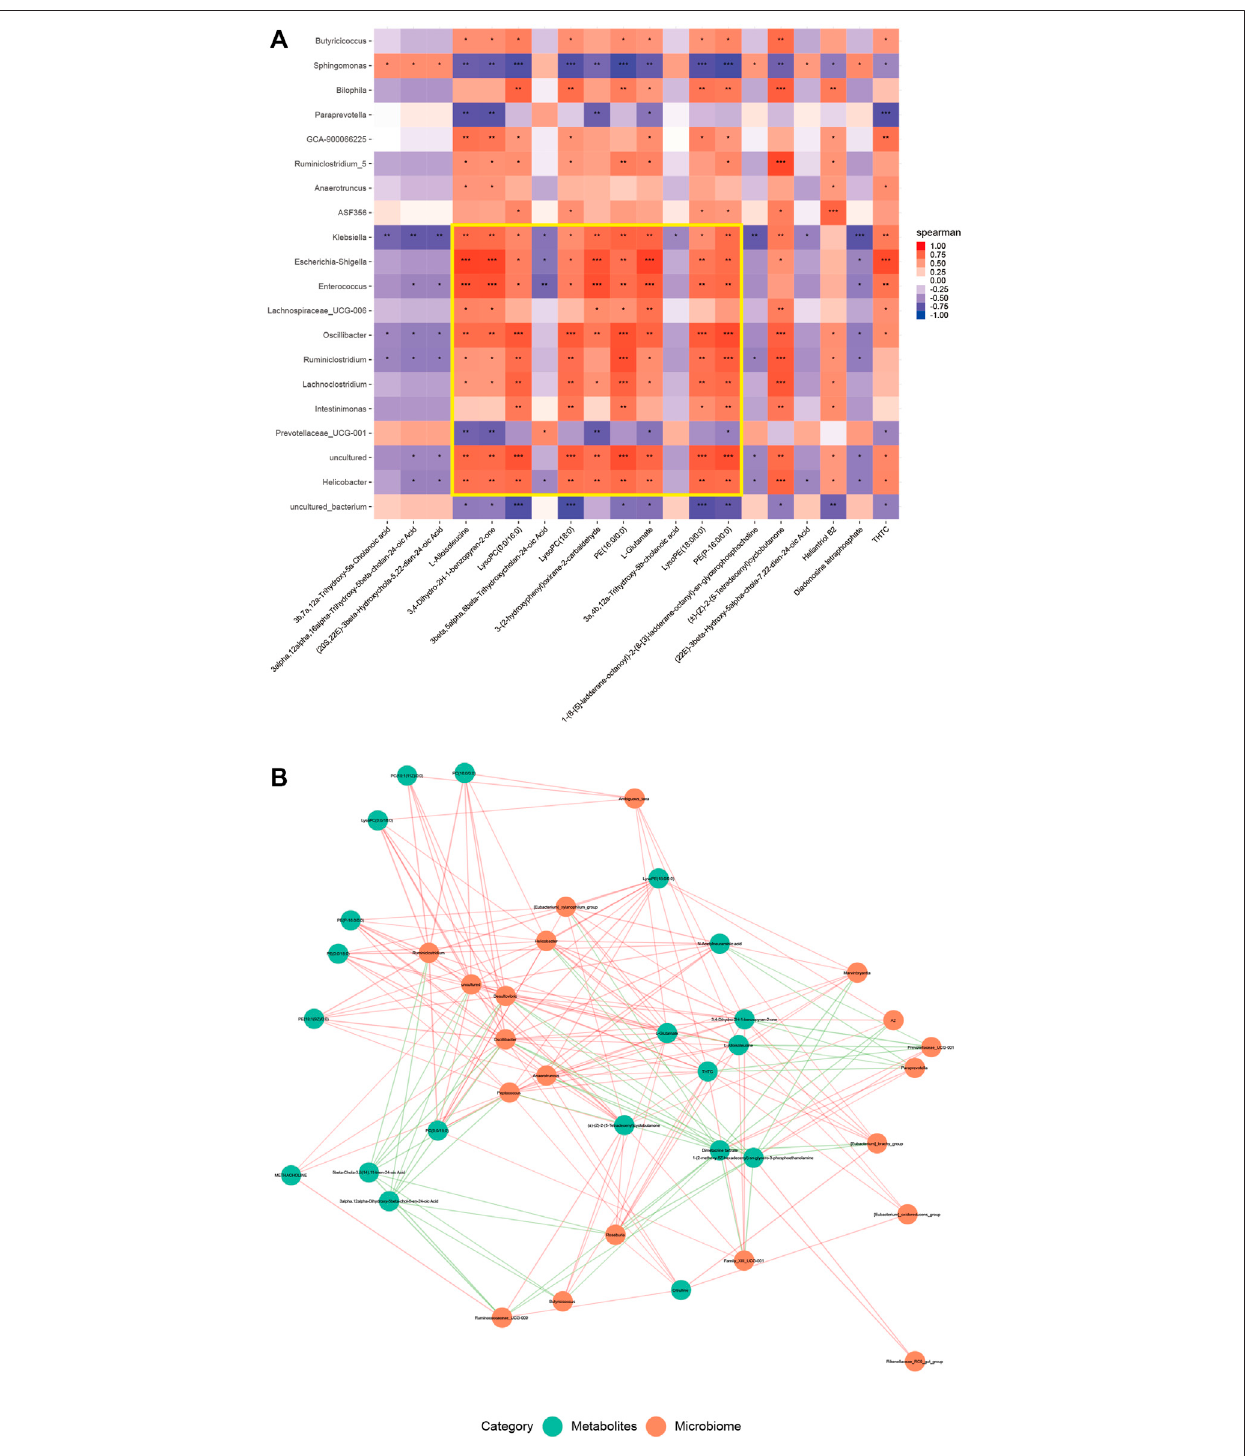
FIGURE 5 | Thecontentsofintestinalmetabolitesinmicecorrelatedwiththeabundanceofmicro fl ora. (A) Heatmapofthe fi rst20differentmicro fl oraandthe fi rst20different metabolitesintheDSSandSEA50 μ g+DSSgroups.Thehorizontalaxisrepresentsthedifferentialmetabolites,andtheverticalaxisrepresentsthedifferential fl ora.Eachsmallsquare representsaPearsoncorrelationcoef fi cient,indicatingthecorrelationbetweenthecorrespondingmetaboliteandthebacterialcommunity.Thevalueisbetween – 1and1.Thecloser thevalueto0,thelowerthecorrelation,andthecloserthevalueto – 1or1,thehigherthecorrelation.Redrepresentsapositivecorrelation,andblueanegativecorrelation;the darkerthecolor,thestrongerthecorrelation.Theasteriskindicatesthe p valueofthecorrelationcoef fi cient,indicatingwhetherthecorrelationissigni fi cant. (B) Correlationdiagramof the fi rst20differentmicro fl oraandthe fi rst20differentmetabolitesintheDSSandSEA50 μ g+DSSgroups.Eachgreendotrepresentsadifferentialmetabolite,andeachorangedot representsadifferential fl ora.Thedistancebetweenthetwolinesrepresentsthesizeoftheircorrelation,andtheclosertheline,thegreaterthecorrelation.Inaddition,differentcolors represent positive and negative correlations, with red representing positive values and green representing negative values.